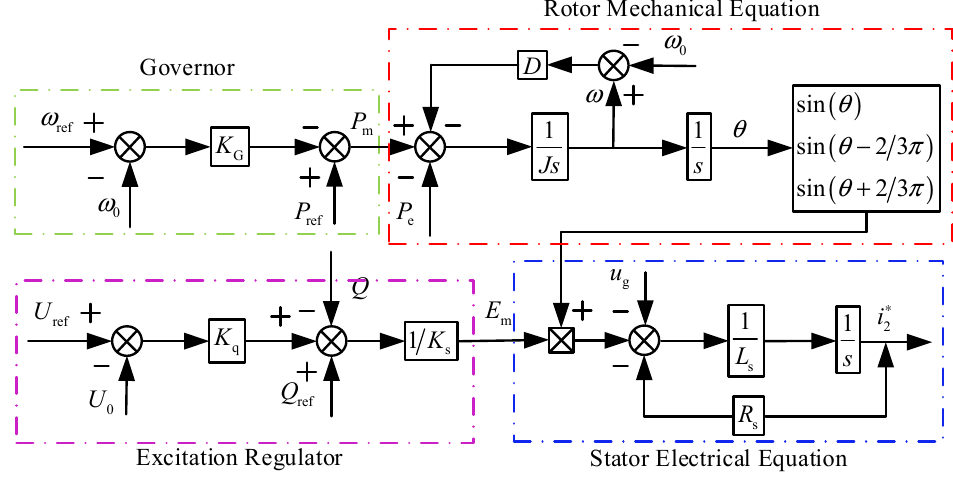
Figure 7. Control principle block diagram of virtual synchronous generator.